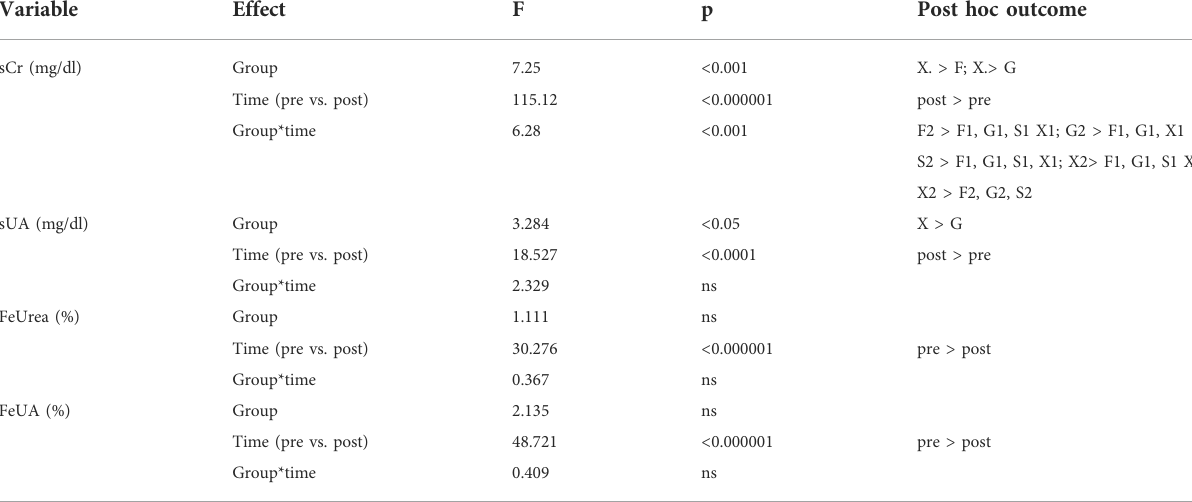
TABLE 6 The in fl uence of different interventions on serum biomarkers (two-way ANOVA).